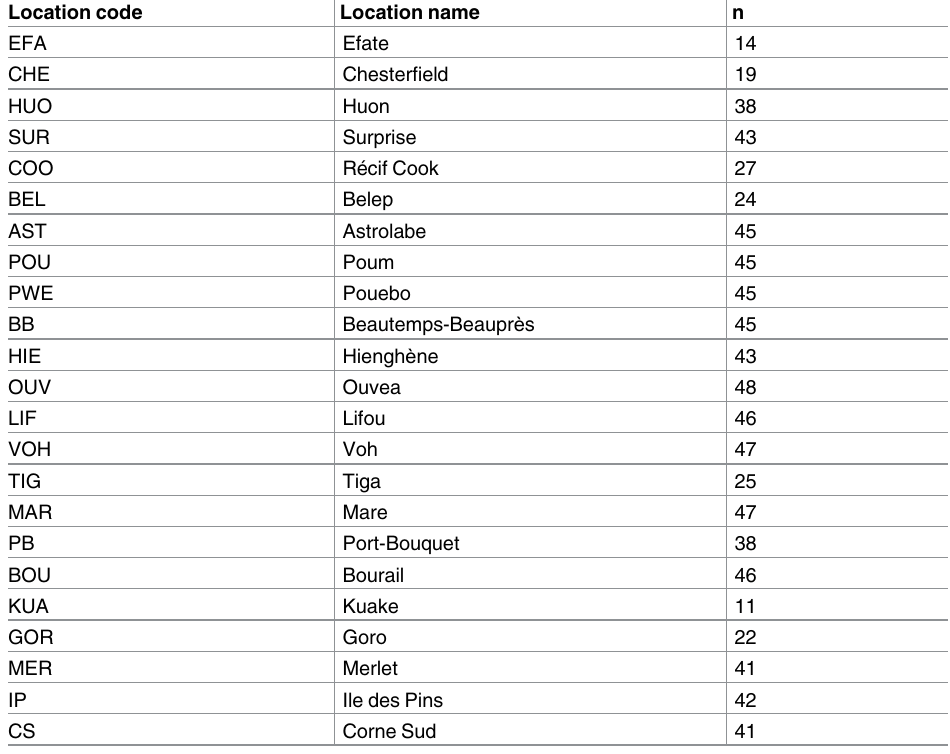
Table 2. Location names and number of specimen collected (n) per location for genetic